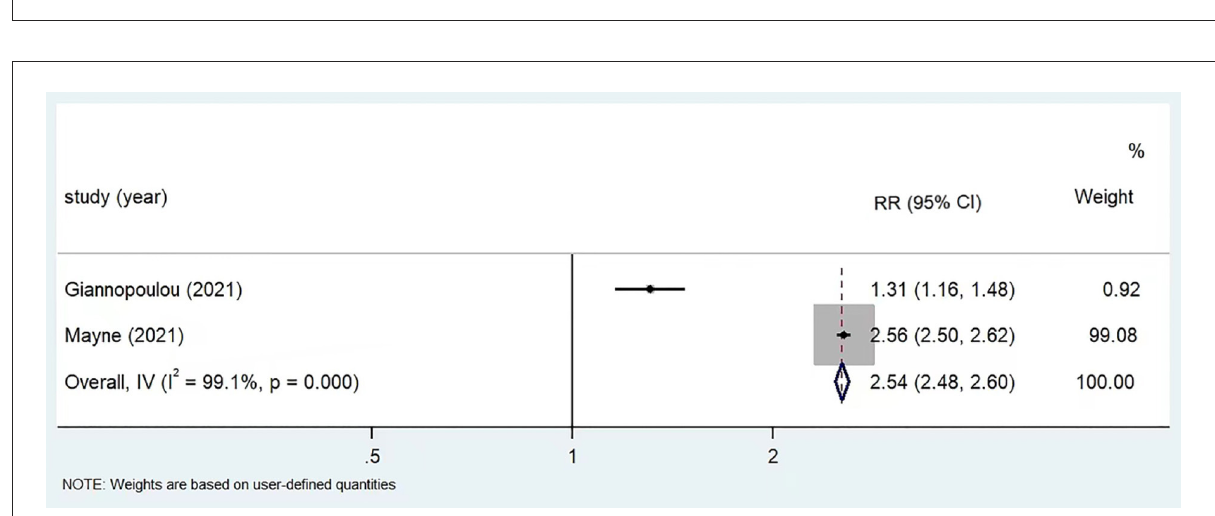
FIGURE3 Meta-analysis of prevalence of depression before and post COVID-19 in children and adolescents by using PHQ-9 ( n = 3).